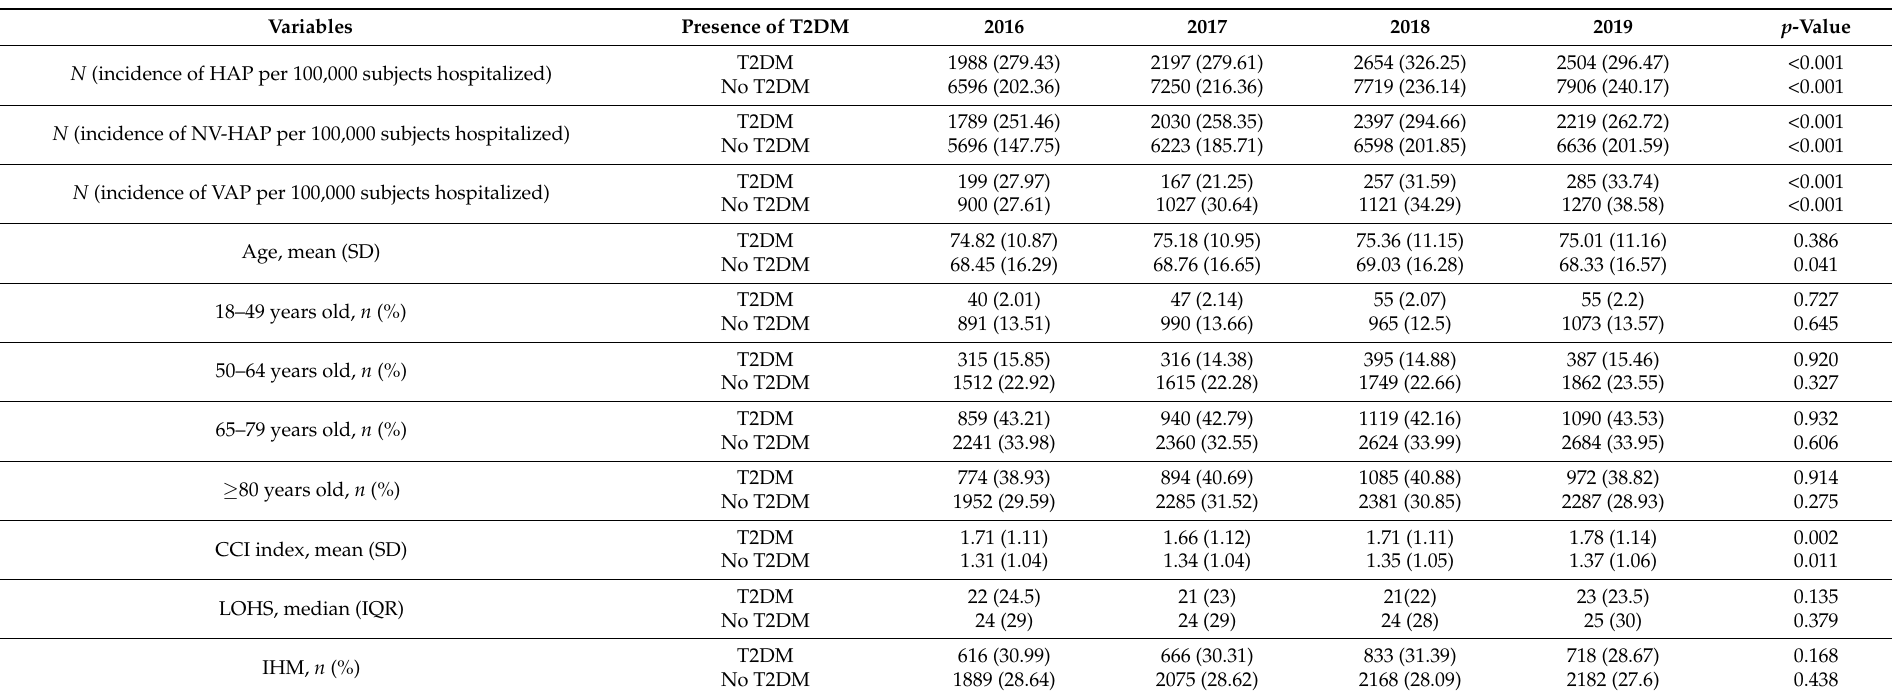
Table 1. Incidence, clinical characteristics, and in-hospital outcomes of patients who developed hospital-acquired pneumonia (HAP) in Spain from 2016 to 2019 according to the presence of T2DM.